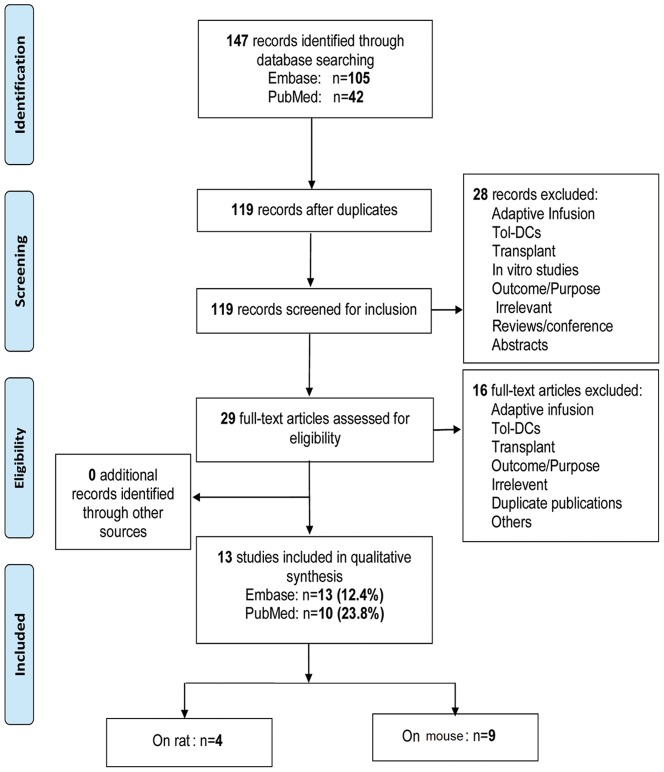
Flow diagram for selection of studies.